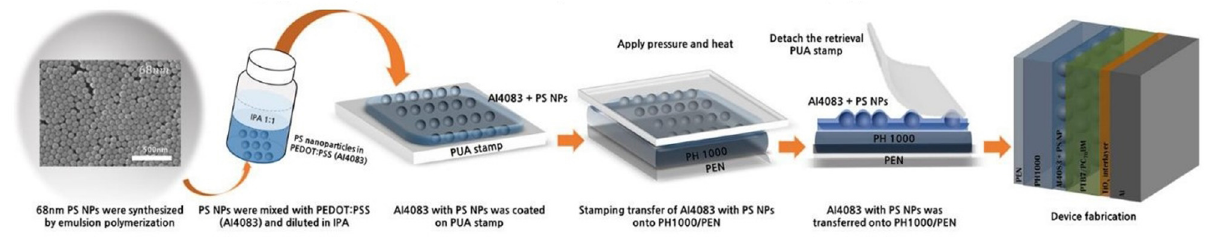
Figure 6: The stamping transfer process of the PPy NPs:PEDOT:PSS layer for PTB7/PC 71 BM based fl exible solar cell [ 27 ] ; Copyright ( 2018 ) Royal Society of